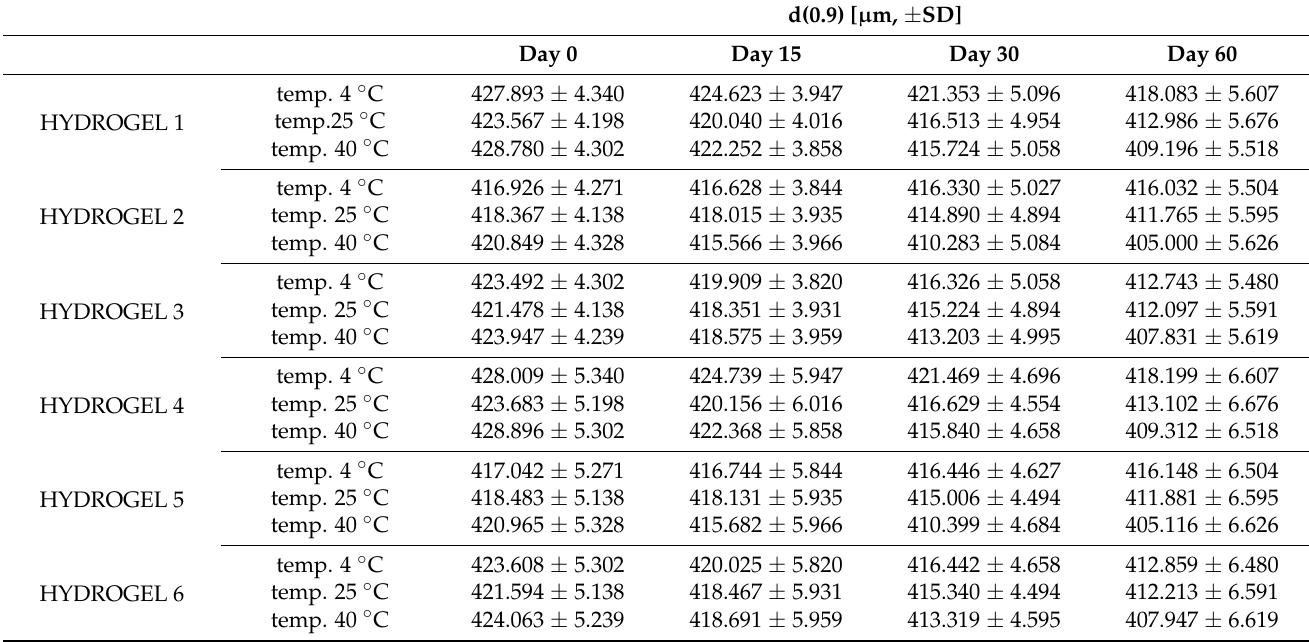
Table 4. Changes in the value of the parameter d(0.9) determined for the hydrogel formulations stored in various temperature conditions (4, 25, 40 ◦ C) for 60